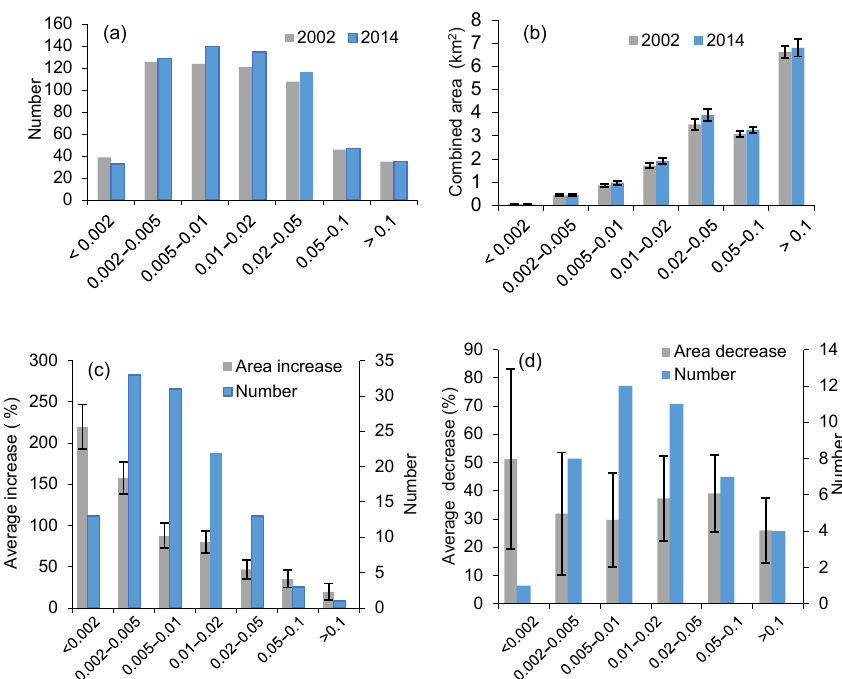
Figure 6. (a) Number of lakes, (b) their combined areas, relative change in lake areas averaged over size category, and number of lakes whose areas (c) increased and (d) decreased. The x axes show size categories (km 2 ) . The vertical bars represent the uncertainty of measurements. Note that different scales are used in (c) and (d) .